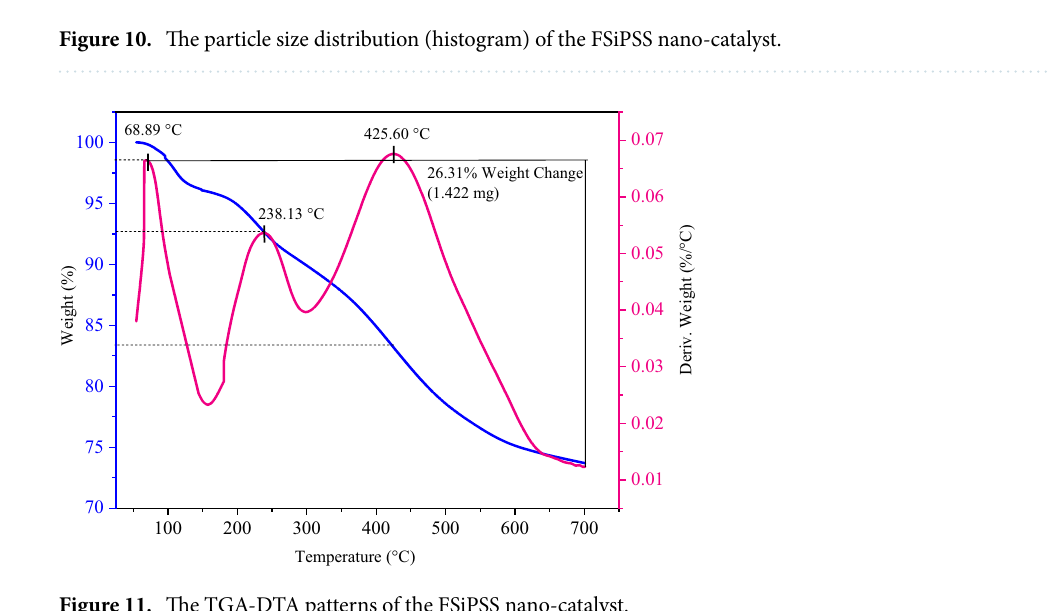
Figure 11. The TGA-DTA patterns of the FSiPSS nano-catalyst.